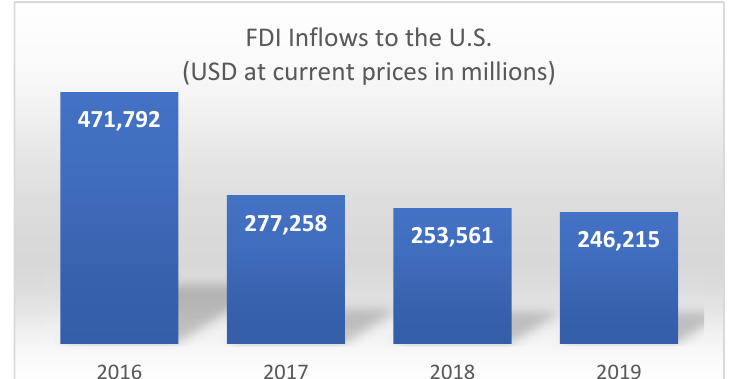
Figure 1. FDI flows into the U.S. (Data source: UNCTADstat).